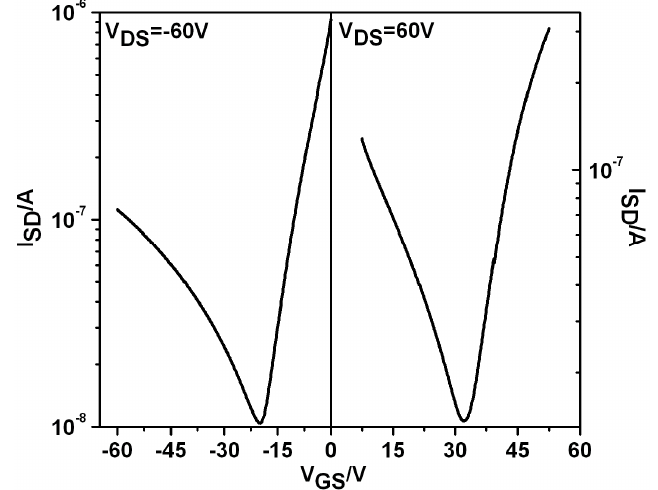
Figure 4. Transfer field-effect transistor (FET) curves for CDT-BTZ-C14,10